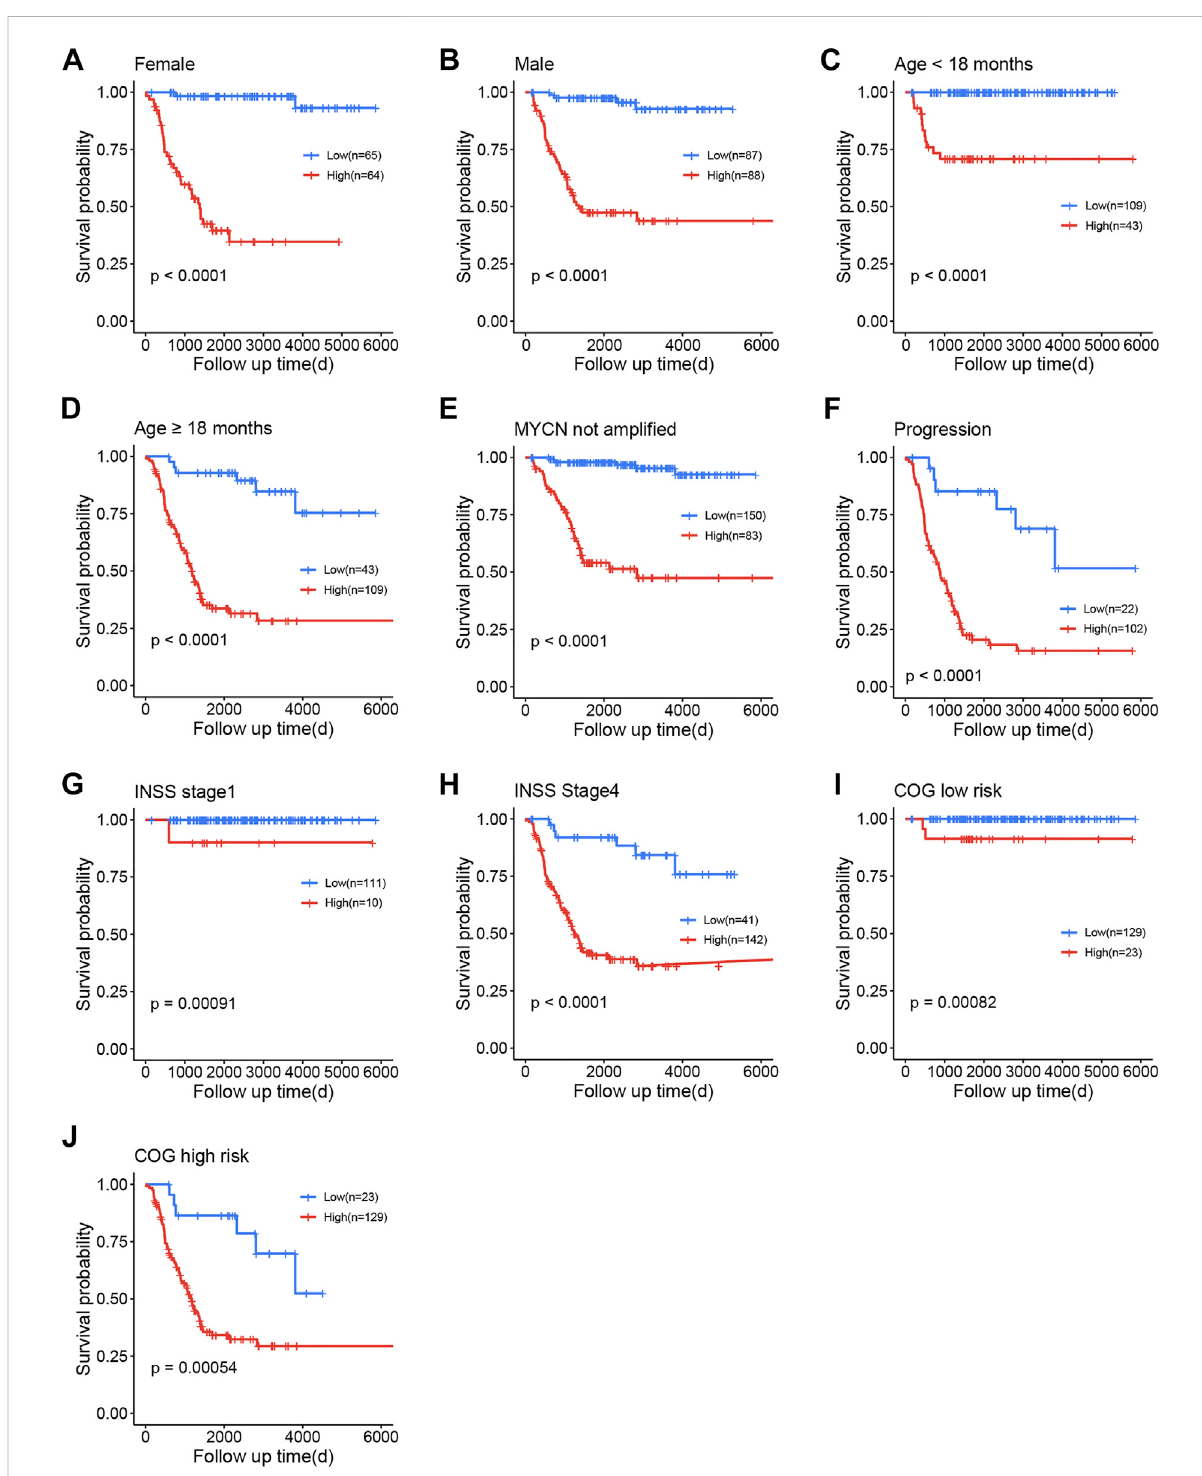
FIGURE 5 Survival analysis of the training cohort. (A) Female. (B) Male. (C) Age < 18 months. (D) Age ≥ 18 months. (E) MYCN not ampli fi ed. (F) Progression. (G) International Neuroblastoma Staging System (INSS) stage 1. (H) INSS stage 4. (I) Children ’ s Oncology Group (COG) low risk. (J) COG high